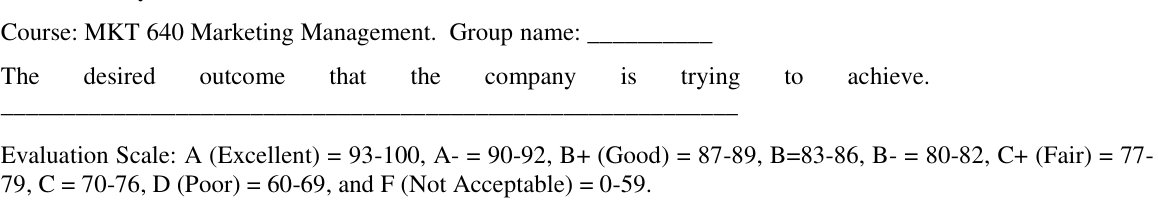
Table 5. Assessment rubric for assignment #5a: Marketing strategy (target market and value proposition) Developing a Marketing strategy: Chernev, 2014, Ch. 7 & appendix A.. Define the master plan that is designed to